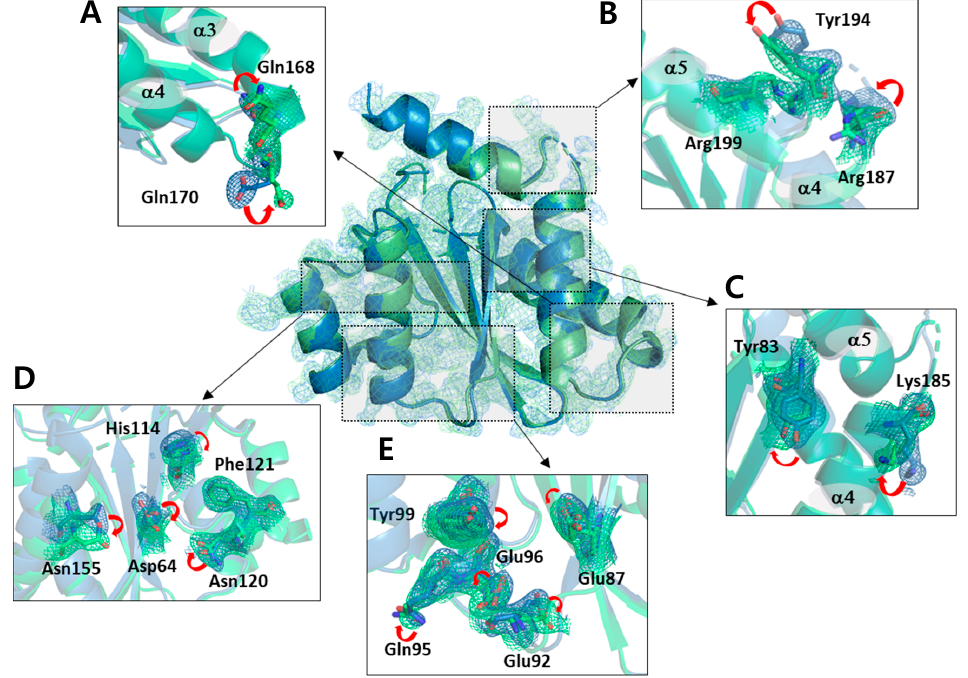
Figure 2. Orientation of the side chains observed at both non-cryogenic and cryogenic structures. The omit maps of side chain are presented at contour level 1.0 σ . The changes of sidechains located in (A) helix III-helix IV loop, ( B ) helix IV-helix V loop, ( C ) the end of beta sheet III and helix IV, ( D ) beta sheet IV and helix II, and ( E ) helix I and beta sheet III.